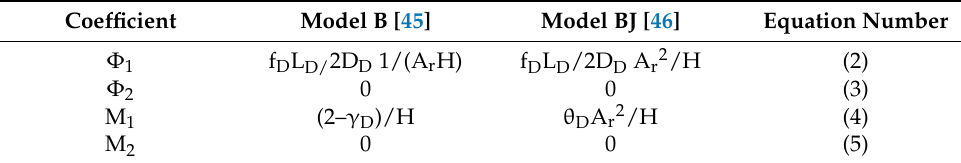
Table 1. Substituting expressions for a dividing